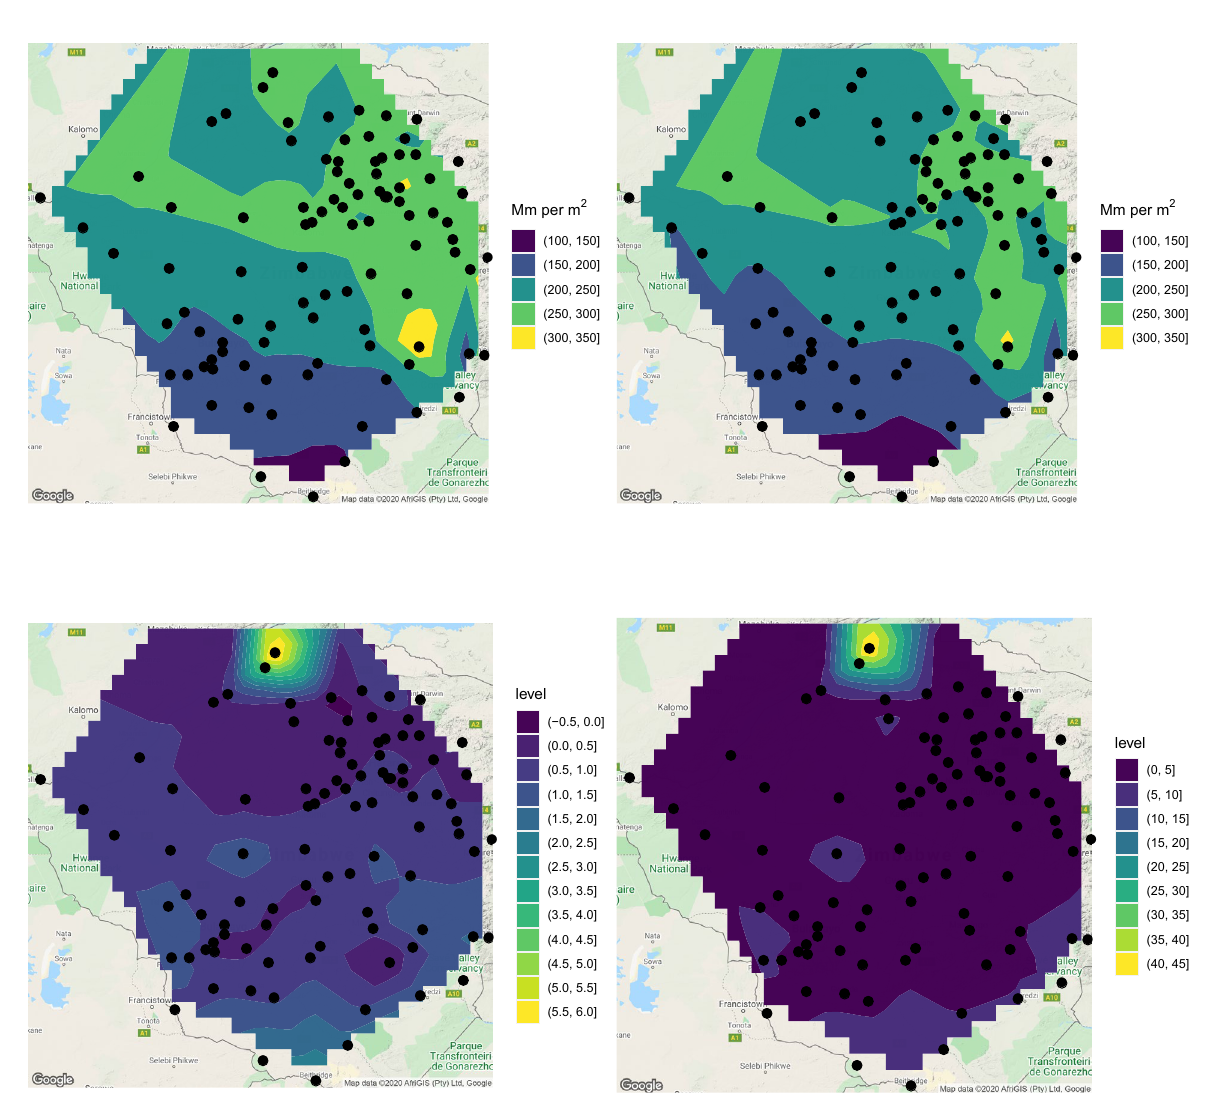
Figure 2. Mean (top left), median (top right), skewness (bottom left) and kurtosis (bottom right) of the annual highest monthly rainfall in Zimbabwe. ggplot2 version 3.3.5, https:// cran.r- proje ct. org/ web/ packa ges/ ggplo t2/ index. html was used for